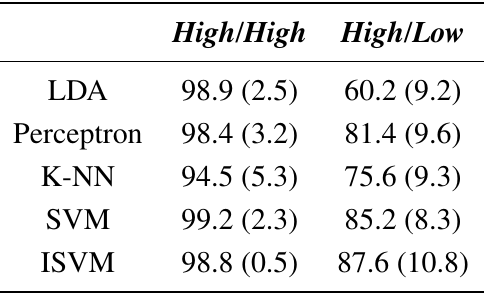
Table 4. Accuracy of different classifiers to identify ethylene. The classifiers were trained with high/blank concentration samples and tested with high/blank samples (first column) and with low/blank samples (second column). The mean and the standard deviation (in parenthesis) of the classifier after 60 random repetitions are